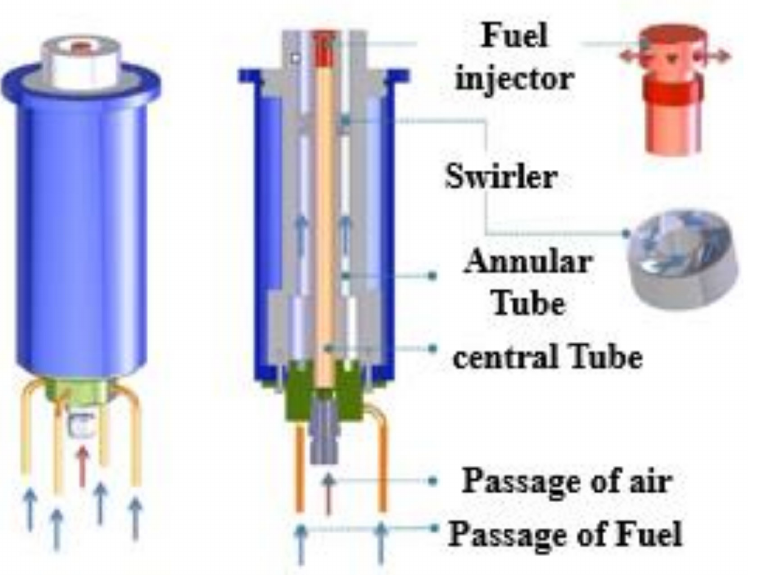
Figure 1. Schematic view of the burner. The annular tube of diameter D e = 38 mm ensured the passage of air by means of four tubes from the bottom. An injector placed at the end of the central tube had eight uniformly distributed holes (3 mm in diameter) for a lateral injection of the methane across the annular air flow. The fuel injector was used to promote mixing in the vicinity of the burner